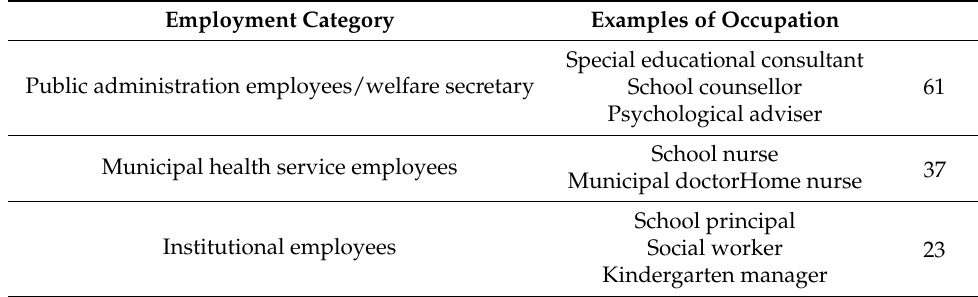
Table 1. Interviewed municipal